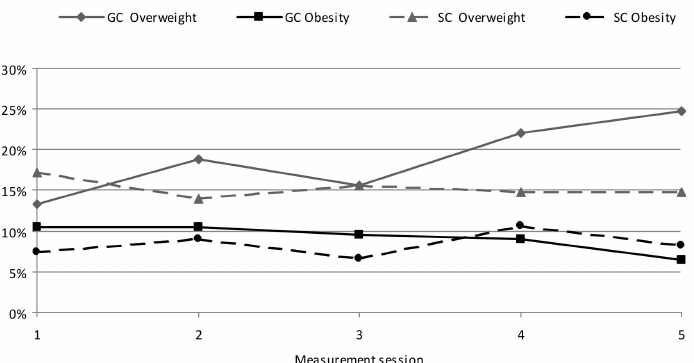
Figure 3. Changes in the percentage of overweight and obesity in children of standard PA (GC) and elevated PA (SC) during the course of the study.